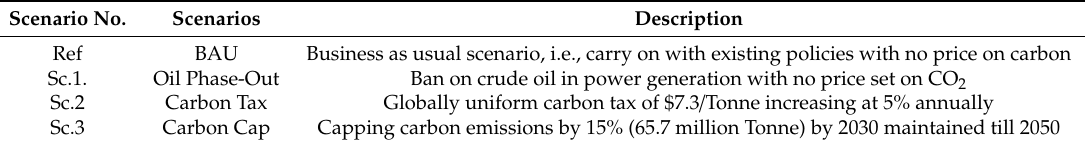
Table 5. Description of CO 2 pricing and technology policy